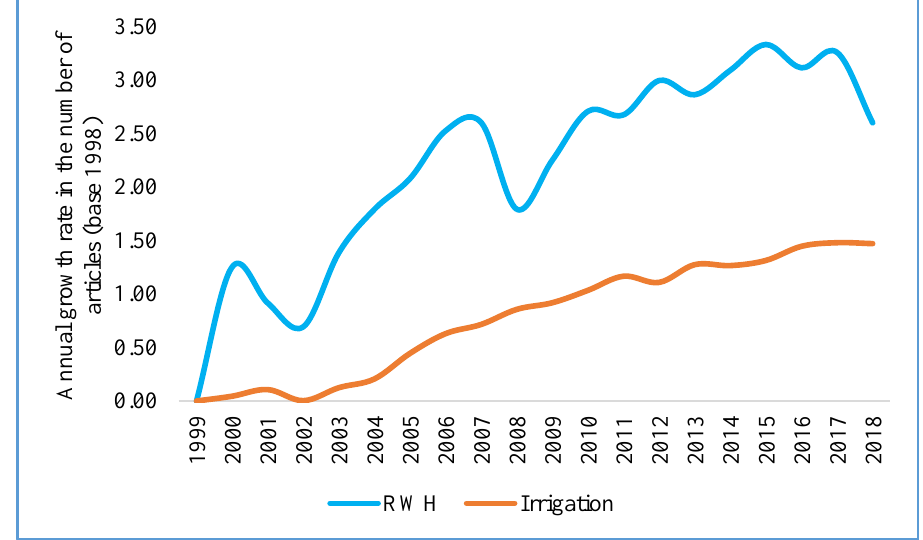
Figure 2. Comparative trends in rainwater harvesting irrigation (RWHI) and irrigation research.